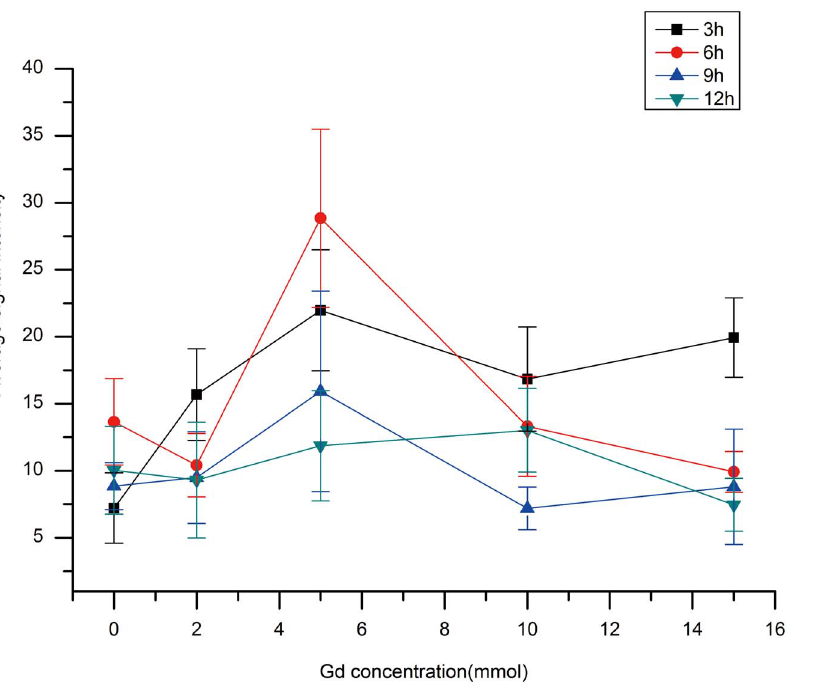
doi:10.1371/journal.pone.0100246.g004